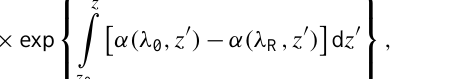
Figure 5. Mean overlap function from 90 (45) cloud and fog free Fig. 5. Mean overlapfunction from 90 (45)cloud and fogfree nighttime one-hourprofiles measured with nighttime one-hour profiles measured with a narrow (wide) field a narrow (wide) field stop is shown in blue on the left (right) panel. Mean contribution to the extinction stop is shown in blue on the left (right) panel. Mean contribution to coefficient, as computed from Eq. (14), is shown in red. The gray lines correspond to the individual the extinction coefficient, as computed from Eq. (14), is shown in profiles. The wide field stop is used since 1 August 2012. red. The gray lines correspond to the individual profiles. The wide field stop is used since 1 August 2012. 36